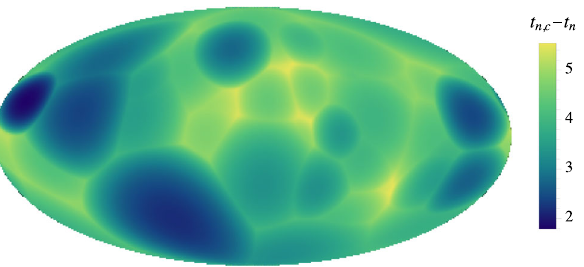
Fig. 3 Mollweide projection of a bubble surface in a many-bubble simulation. The color coding indicates the time when the given part of the bubble surface collided for the first time with another bubble